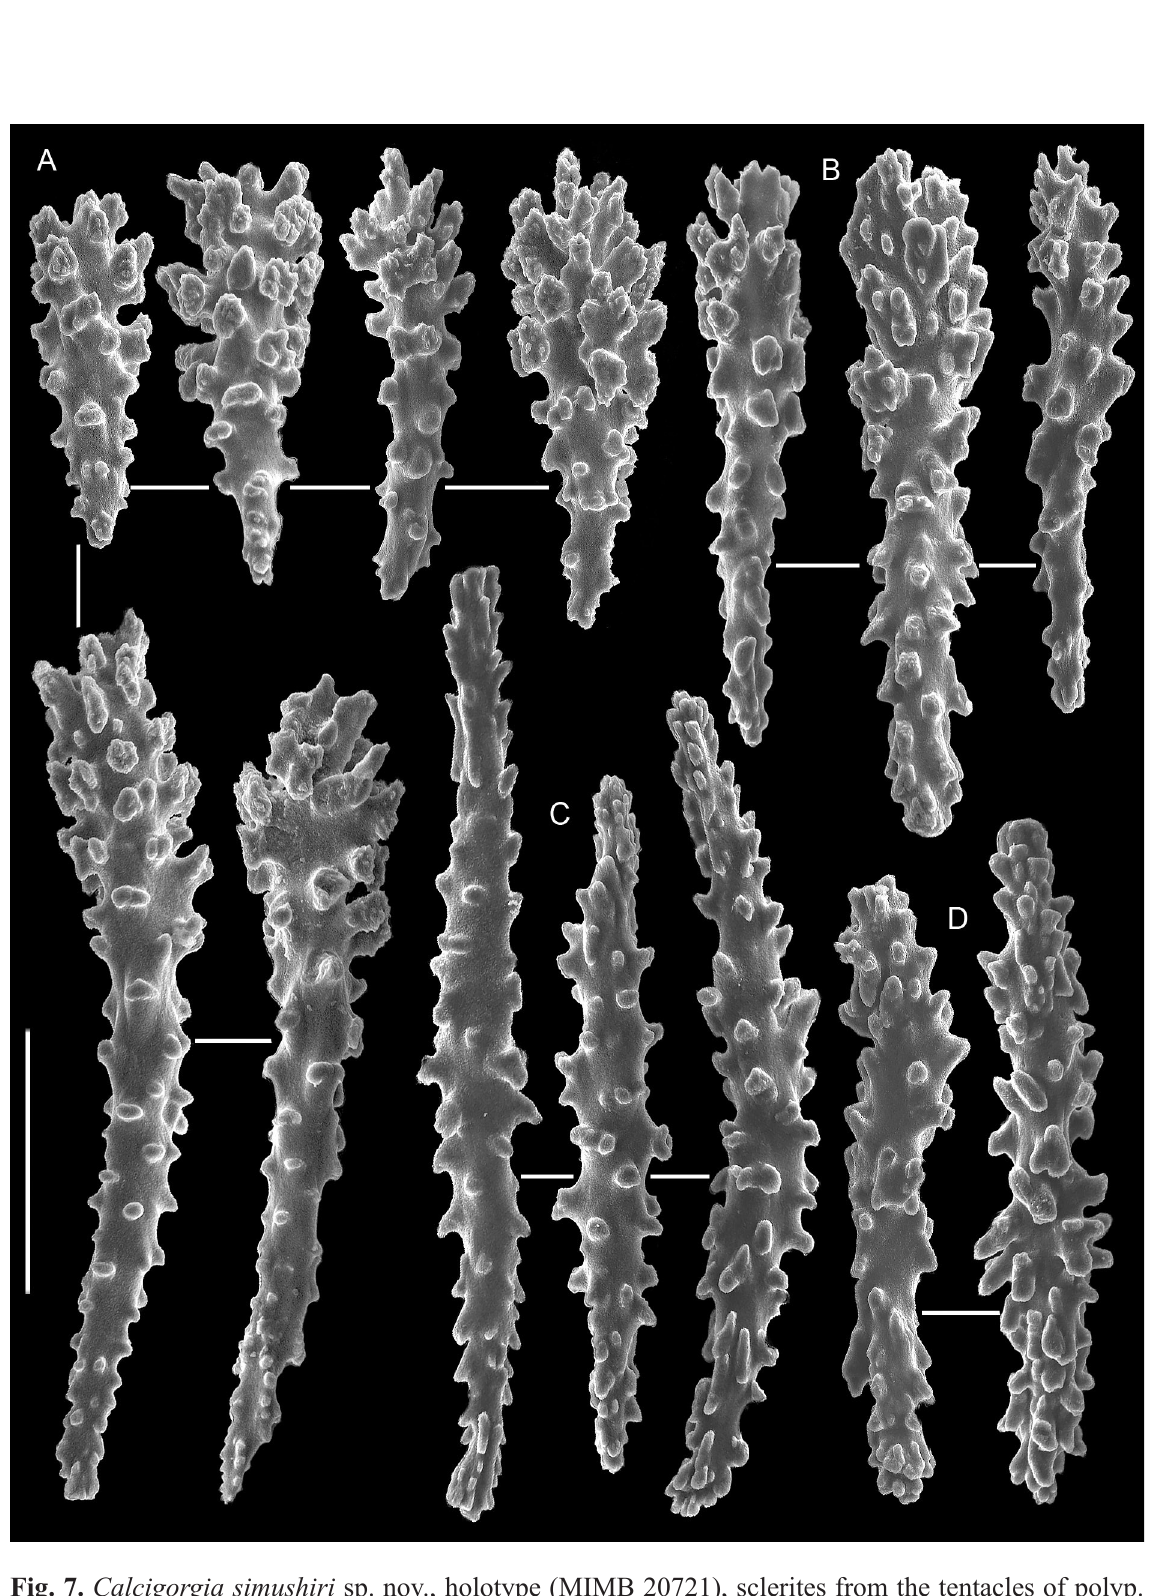
Fig. 7. Calcigorgia simushiri sp. nov., holotype (MIMB 20721), sclerites from the tentacles of polyp. A . Clubs. B . Club-like spindles. C . Spindles ornamented with tubercles. D . Spindles ornamented with conical hillocks inclined toward the spindle ends. Scale bar: 0.1